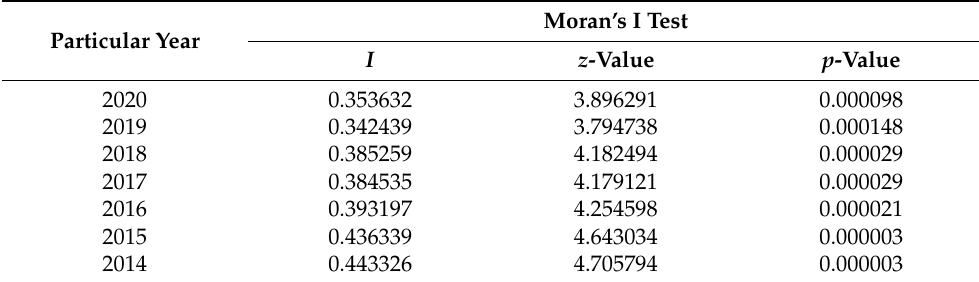
Table 6. Single-variable global Moran’s I test results of ecological